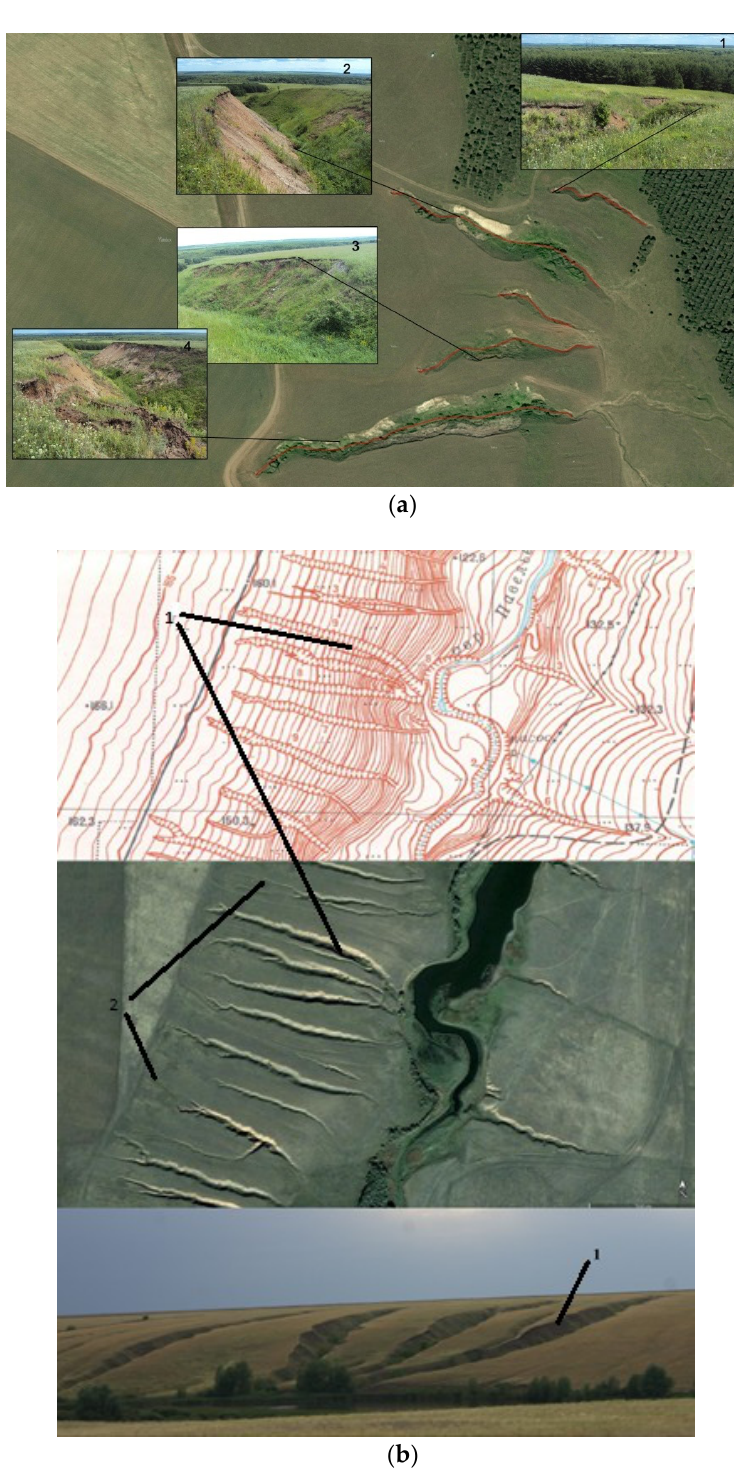
Figure 2. ( a ) Gullies from the satellite image (scale 1:30,000) and during the field study at different development stages; ( b ) Gullies forms (1) on topographic map (scale 1:10,000), satellite image and during the field study (Samara river basin), ephemeral gullies forms (2) on satellite image.